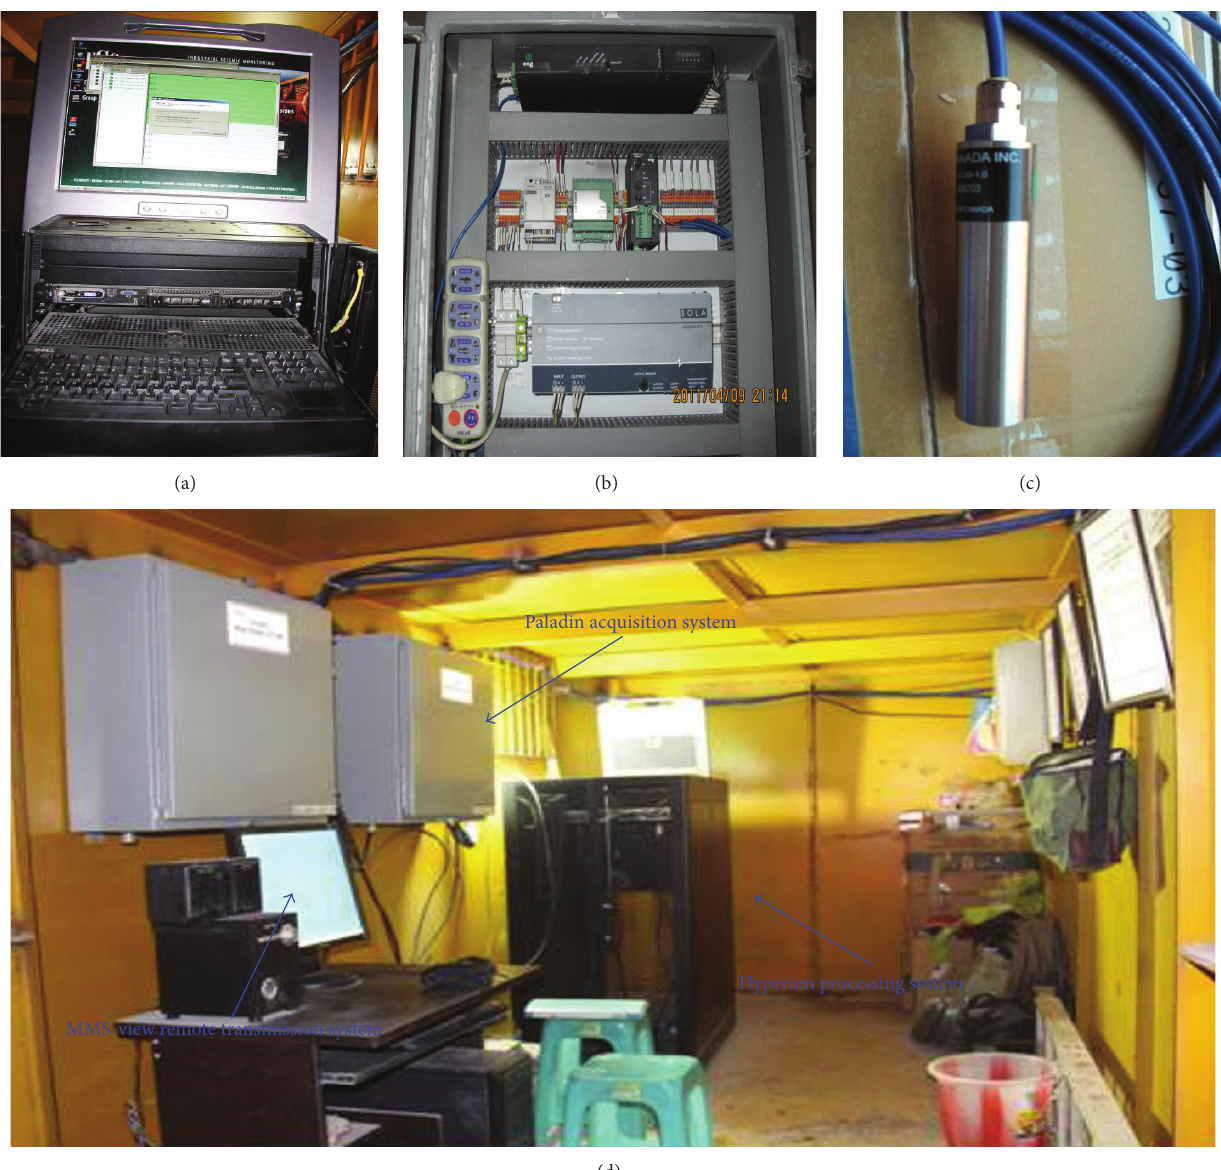
Figure4:Constitutionofmicroseismicmonitoringsystem.(a)Hyperiondigitalsignalprocessingsystem.(b)Paladindigitalsignalacquisition system. (c) Acceleration sensor. (d) Center of the site monitoring